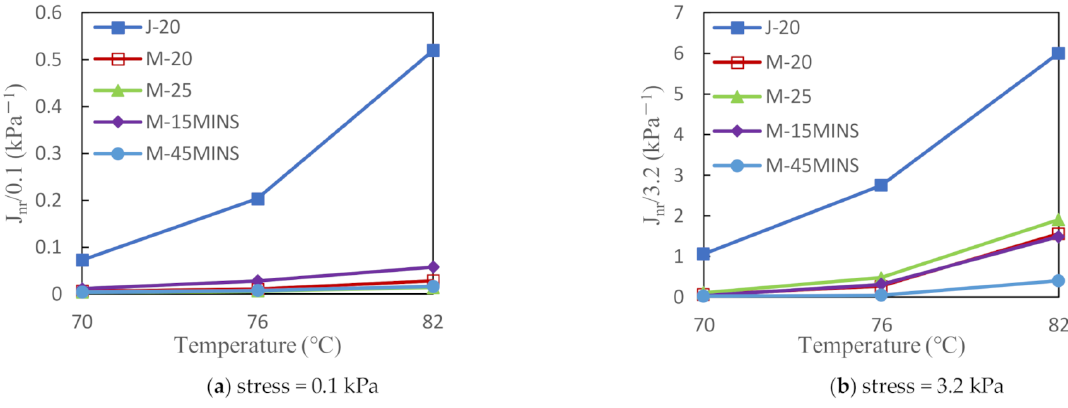
Figure 4. Influence of temperature on unrecovered strain (J nr ) of asphalt binder at different stress